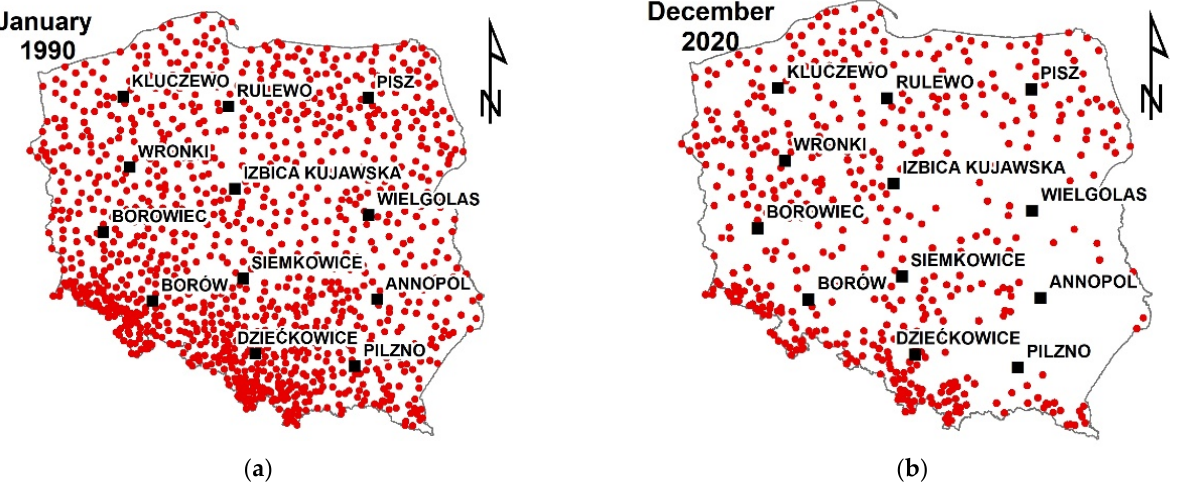
Figure 2. Density of the meteorological stations in the analyzed period: ( a ) in 1990, ( b ) in 2002. The other data used for the presentation of the analyzed concepts include measure- Table 1. Classes of SPI according to the recommendation of KZGW [36]. ments of temperature all over the country and the borders of the country. The first are also Class Values publicly available and may be downloaded from the same locations at which the precipi- tation measurements were made. The boundaries of the country were taken from General Bureau of Geodesy and Cartography (GUGiK = Pol. Generalny Urz ą d Geodezji i Karto- grafii) [32].